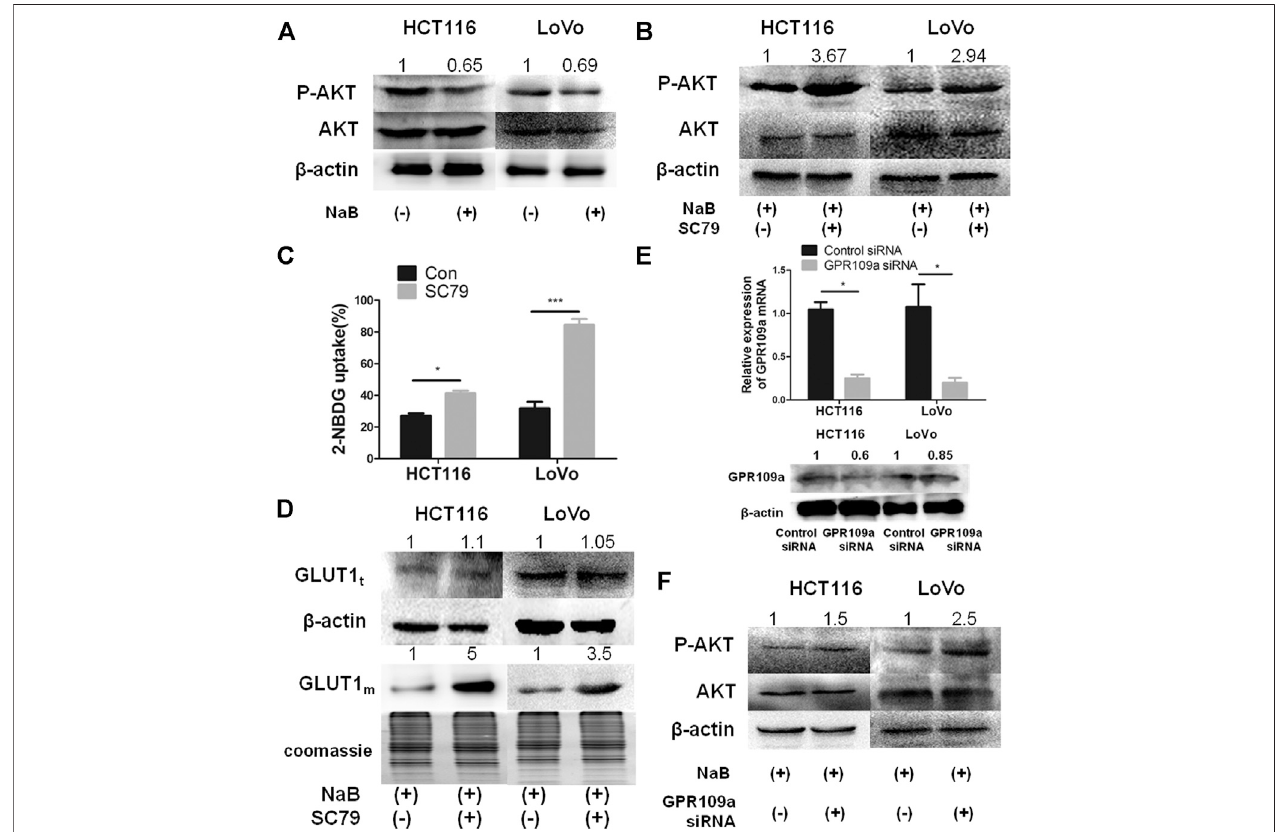
FIGURE2| Theinhibitoryeffectofbutyrate ontheglucoseuptakeofcancerouscolonocyteswasmediatedbytheAKTpathway. (A) TheproteinlevelsoftotalAKT and phosphorylatedAKT (labeledas “ P-AKT ” )weretested bywestern blottinginHCT116 and LoVocellsafter incubating with2 mM butyrate (marked as “ NaB ” ) orPBS vehicle(markedas “ Con ” )for24 h. (B) WhenHCT116andLoVocellswereco-incubatedwith2 mMbutyrateand10.96 μ MSC79orincubatedwith2 mMbutyratealone for 24 h, western blotting was applied to measure the protein levels oftotal AKT and phosphorylated AKT. (C) 2-NBDG, an indicator of glucose uptake ef fi ciencies wasmeasuredusing fl owcytometryinHCT116andLoVocellsafterincubatingwith2 mMbutyrateorPBSvehiclefor24 h. (D) TheproteinlevelsofGLUT1inwholecells (labeled as “ GLUT1 t ” ) or cell membrane (labeled as “ GLUT1 m ” ) were tested using western blotting, after HCT116 and LoVo cells were incubated with 2 mM butyrate alone or the combination of 2 mM butyrate and 10.96 μ M SC79 for 24 h. Coomassie bright blue staining of polyacrylamide gels represented the concentration of cell membrane proteins. (E) The mRNA and protein levels of GPR109a were tested by qPCR and western blotting, respectively, at 24 h after the transfection of GPR109a- targetingsiRNA orcontrolsiRNA intoHCT116 andLoVocellsalongwiththeadditionof2 mMbutyrate. (F) TheproteinlevelsoftotalAKTand phosphorylatedAKTwere tested using western blotting in HCT116 and LoVo cells being incubated with 2 mM butyrate and transfected with GPR109a speci fi c siRNA or control siRNA for 24 h. The error bars showed standard deviations from independent triplicates. * p < 0.05, *** p < 0.001.